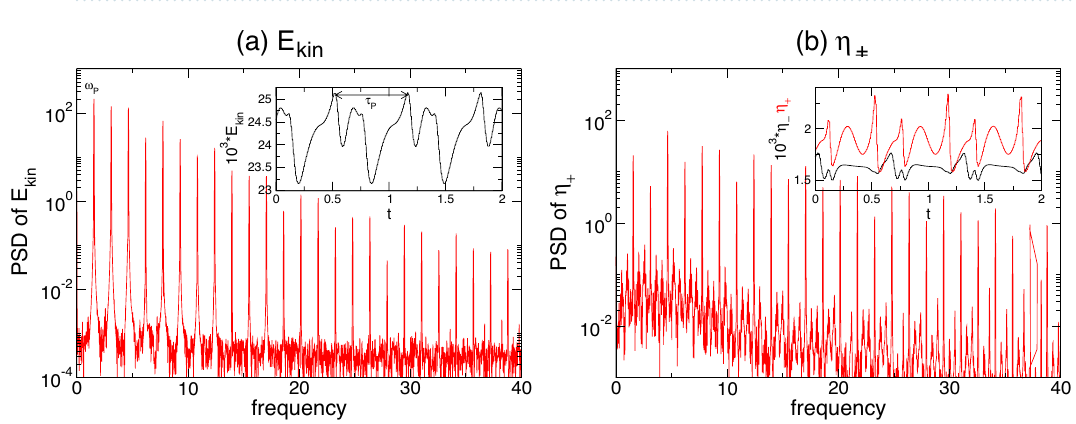
0.641 . Also see the movie, movie_pV1_alpha0.avi, in SMs. ≈